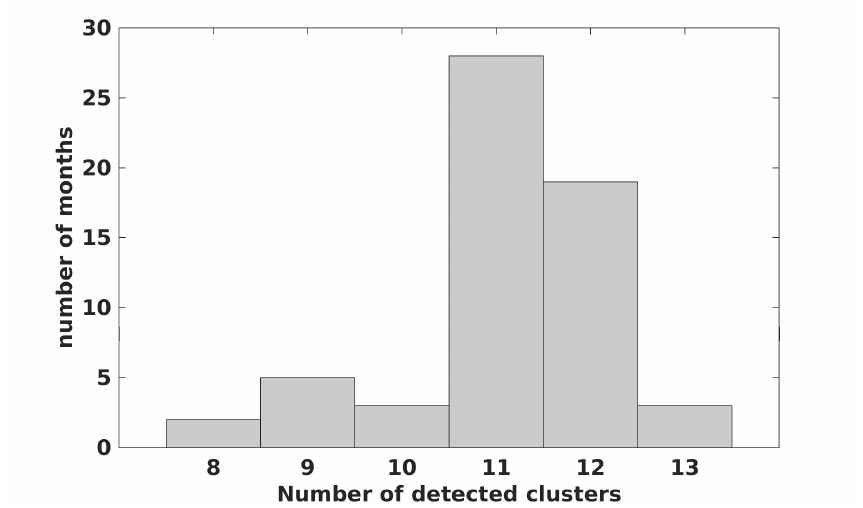
Figure 4. Distribution of the number of clusters detected by Hierarchical Agglomerative Clustering